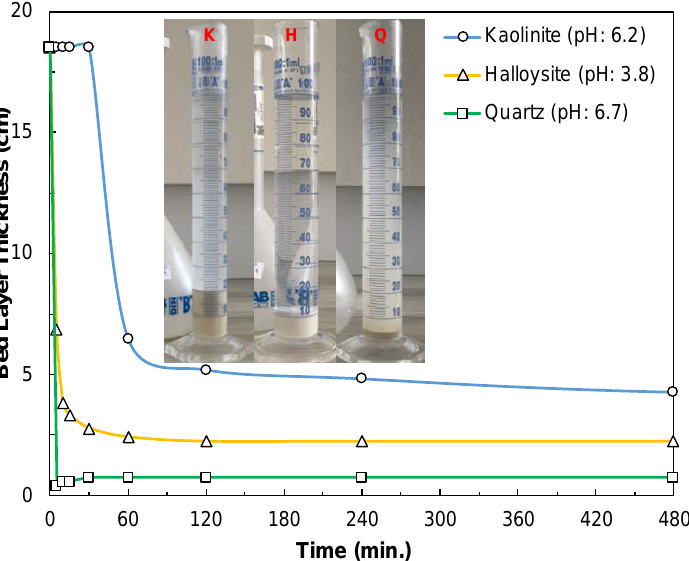
Figure 7. Time-dependent variation of the bed layer thickness of halloysite, kaolinite, and quartz min- erals at natural pHs and room temperature along with the images for the dispersion/sedimentation experiments at 1440